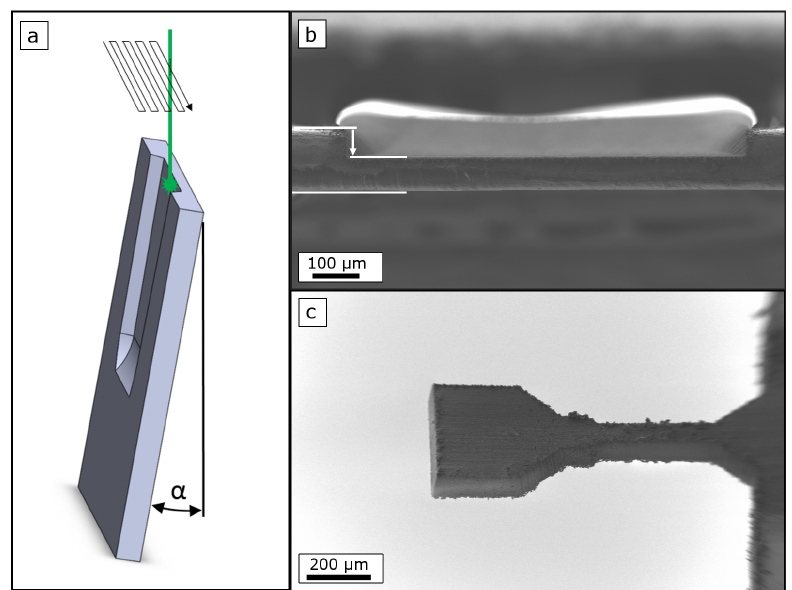
Figure 11. Fs-laser processing allows a local reduction of the foil thickness. ( a ) The thinning needs to be performed under the resulting, parameter dependent taper angle α . ( b ) FEP VDA foil thin section with a thickness of ca. 80 µ m. ( c ) Tensile specimen cut into a thinned